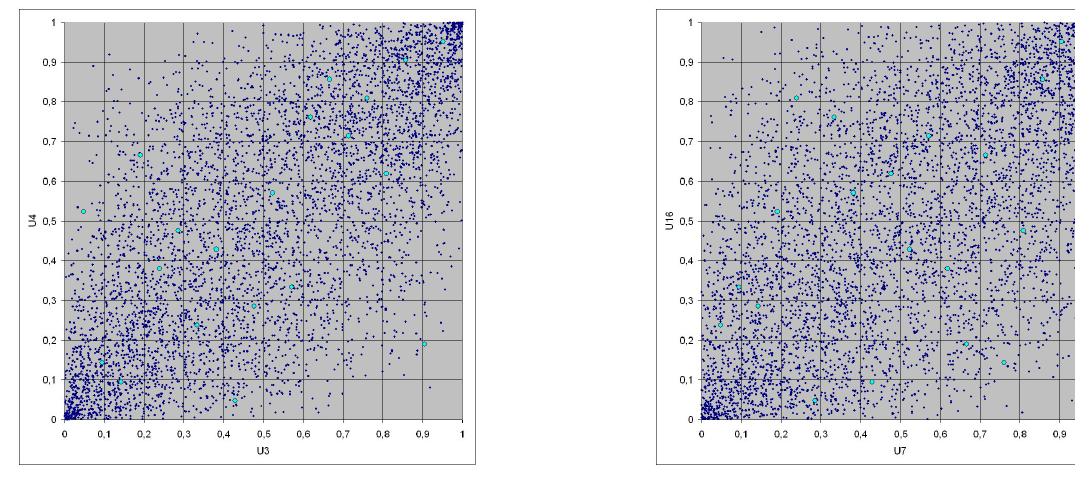
Figure 33: Gaussian copula, II